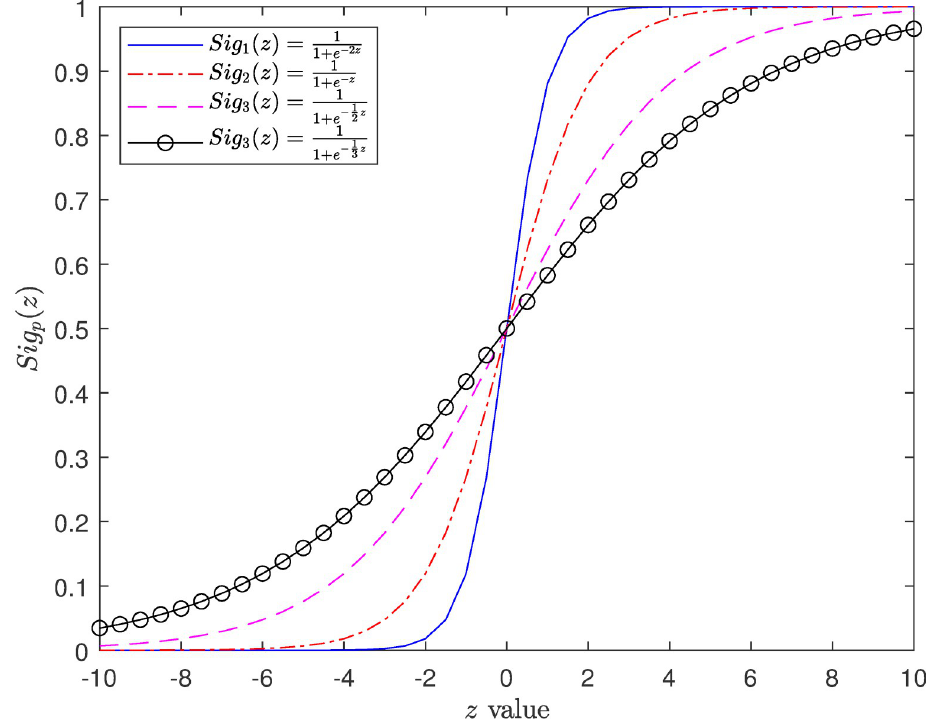
Fig 2. Curves of sigmoid functions used in our proposed